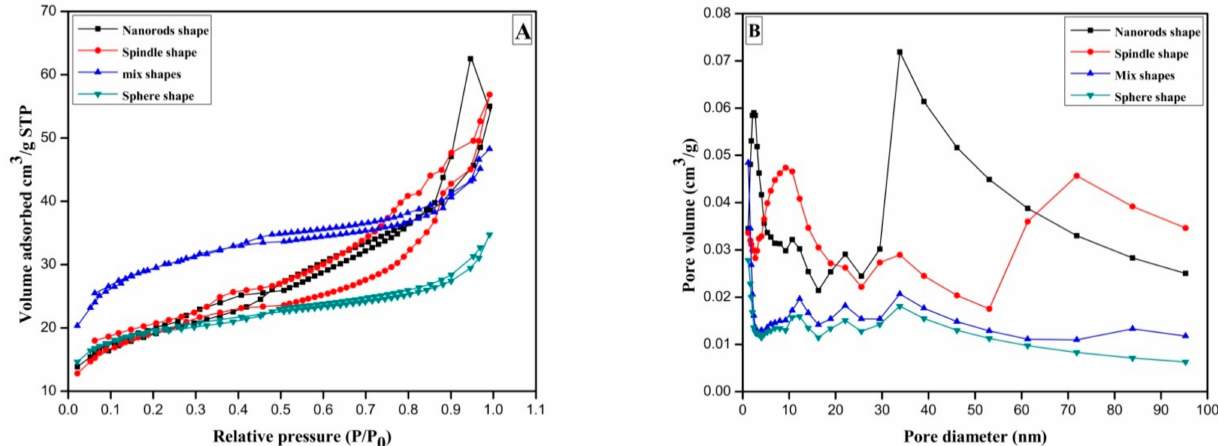
Figure 3. ( A ) N 2 adsorption-desorption curve of the CeO 2 sphere; mixed shape CeO 2 ; CeO 2 spindle and CeO 2 nanorods prepared by annealing Ce(OH) 3 at 500 ◦ C for 3 h; ( B ) Barrett-Joyner-Halenda (BJH) plots of CeO 2